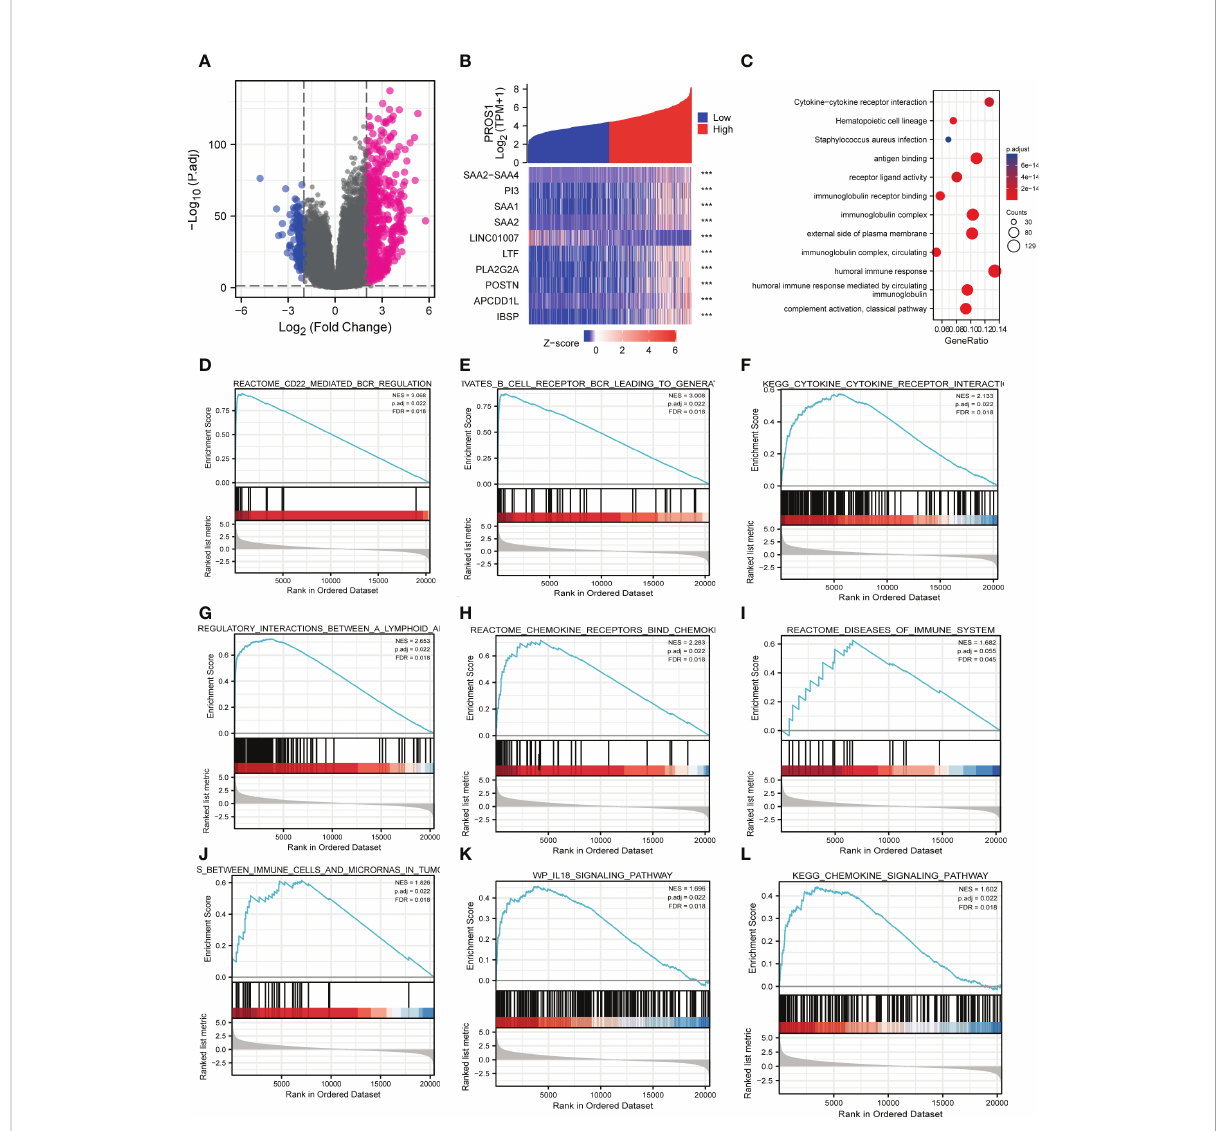
FIGURE 3 PROS1-related differentially expressed genes (DEGs) and functional enrichment analysis of high PROS1 expression glioma. (A) DEGs between glioma patients with high- and low- PROS1 expression. (B) Heat map of the 10 differentially expressed genes in the high- and low-PROS1 expression groups (***, P < 0.001). (C) GO and KEGG analysis of DEGs in glioma. Only pathways with a P -value <0.05 are presented. Enrichment plots from gene set enrichment analysis (GSEA). Several pathways and biological processes were enriched, including the (D) CD22 mediated regulation, (E) B cell receptor BCR, (F) cytokine receptor interaction, (G) regulatory interaction between A lymphoid, (H) chemokine receptors bind, (I) diseases of immune system, (J) immune cells and microRNAs in tumor, (K) IL18 signaling pathway, (L) chemokine signaling pathway. High and low expressions were de fi ned as the PROS1 transcript level is more or less than the median level of all